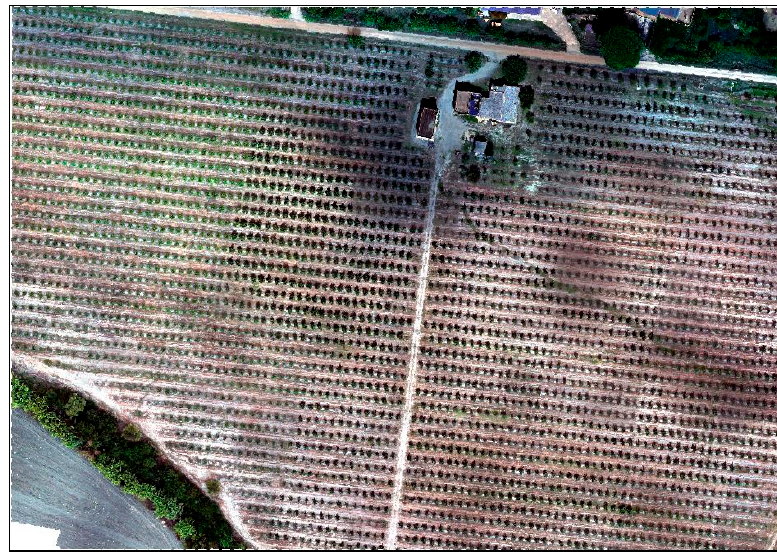
Figure 2. Orthophoto mosaic from aerial multispectral imagery collected using UAVs. The output obtained from the image processing in the Agisoft Metashape software was a digital surface model (DSM).